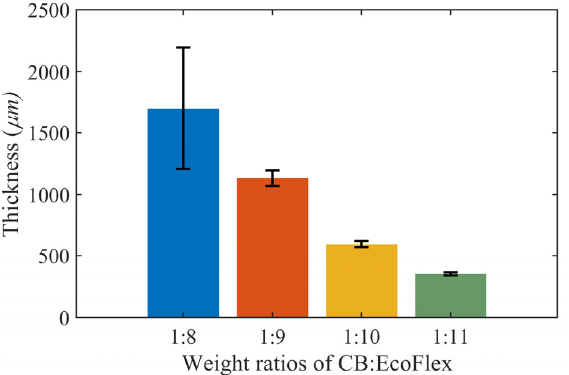
Figure 6. Average surface thickness across twelve samples of CB:Ecoflex grouped by different weight ratio percentages.